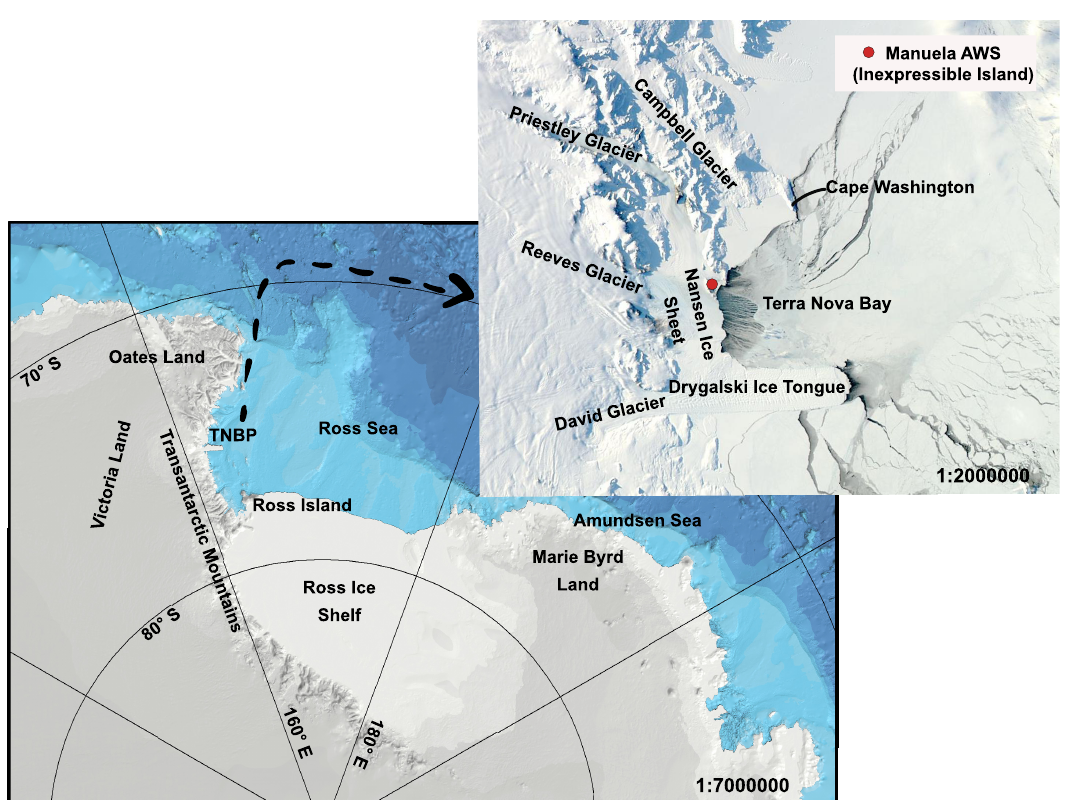
Figure 1. Map of Terra Nova Bay area. Satellite image for 20 September 2012 from the NASA Worldview application (https://worldview.earthdata.nasa.gov), part of the NASA Earth Observing System Data and Information System